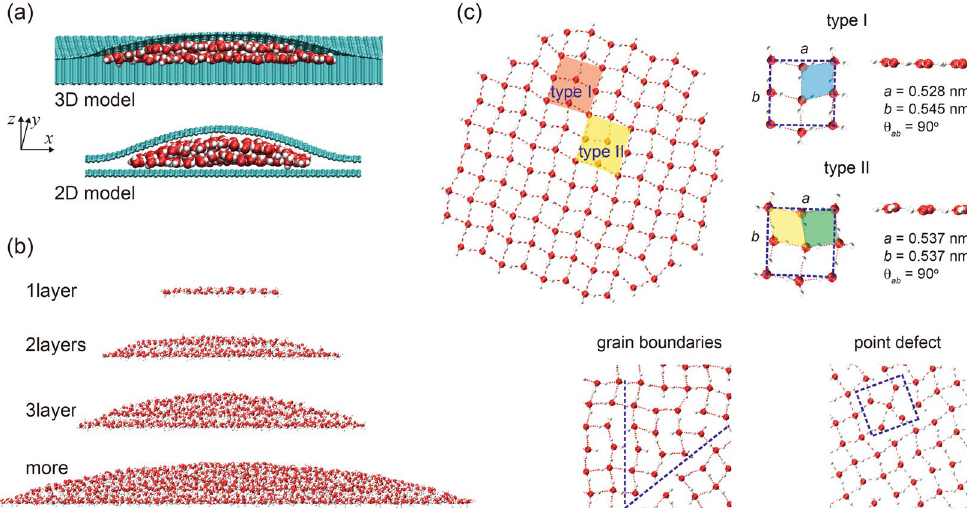
Figure 1. ( a ) Cross-section simulation snapshots of 3D (hemispheric) and 2D (half-cylindrical) models for water encapsulation under graphene. ( b ) Mono-, bi- and tri-layer water structures in the 3D model, with the number of water molecules N W = 115, 546, 986 at 300 K, which disappear with N W > ~1000. ( c ) Structures of monolayer water showing ordered structures of two different lattice types, as well as defects (grain boundaries and point defects). The lattice constants are